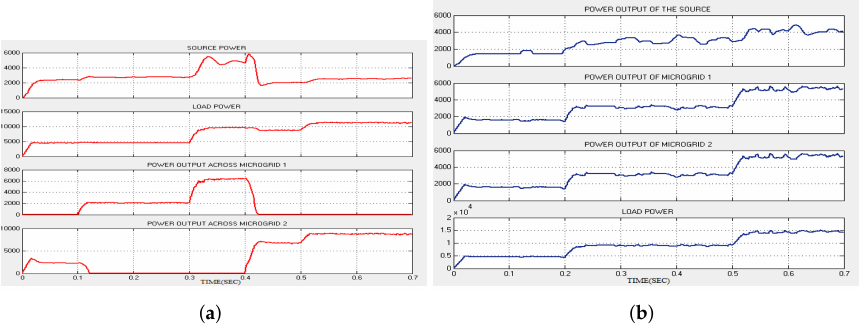
Figure 20. Power waveforms of source, load, Microgrid 1, and Microgrid 2 ( a ) under different tariff conditions and ( b ) under equal tariff conditions.